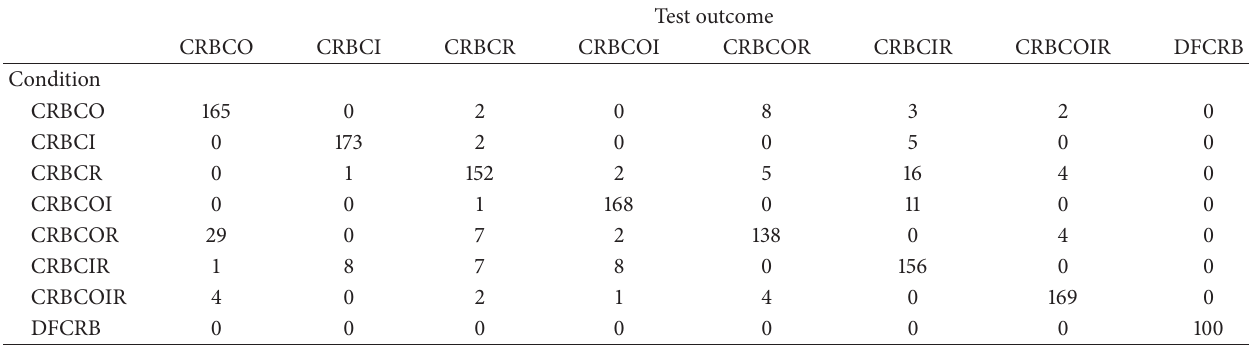
Table 5: Classification result of the proposed bearing fault diagnosis method using a confusion matrix, where k -fold cross validation is